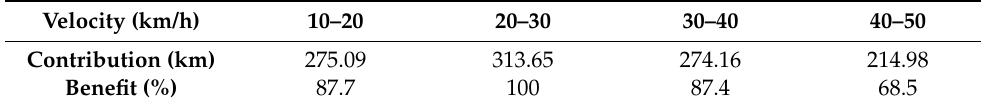
Table 2. Velocity’s relationship to Contribution and